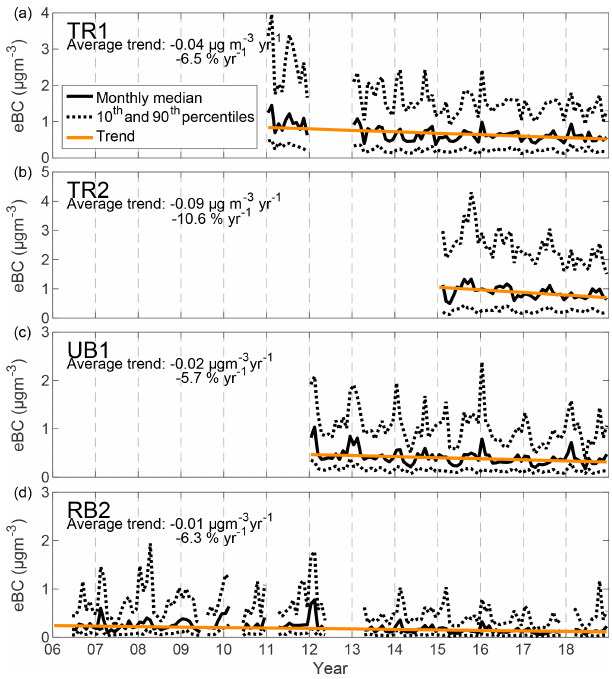
Figure 4. Time series and trends in eBC concentration at TR1, TR2, UB1, and RB2. The solid black line represents the monthly me- dians, the dashed lines represent the 10th and 90th monthly per- centiles, and the orange line is the fitted long-term